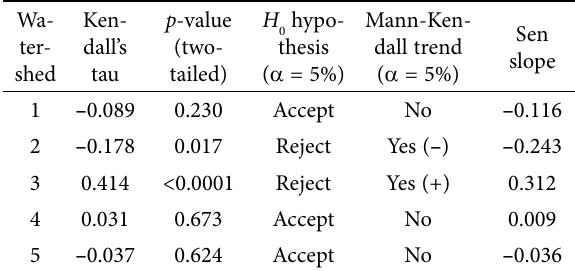
Table 5. Mann-Kendall trend and Sen slope analysis